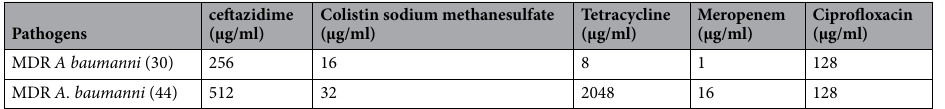
Table 5. Distribution of minimal inhibitory concentration (MIC) of MDR A. baumannii.